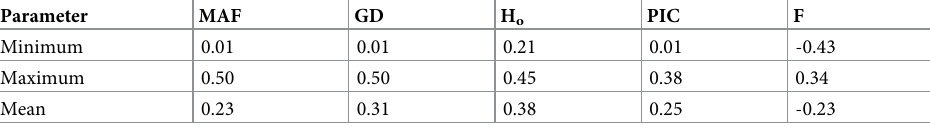
MAF = minor allele frequency, GD = the Genetic distance, Ho = the Observed heterozygosity, PIC = the polymorphic information